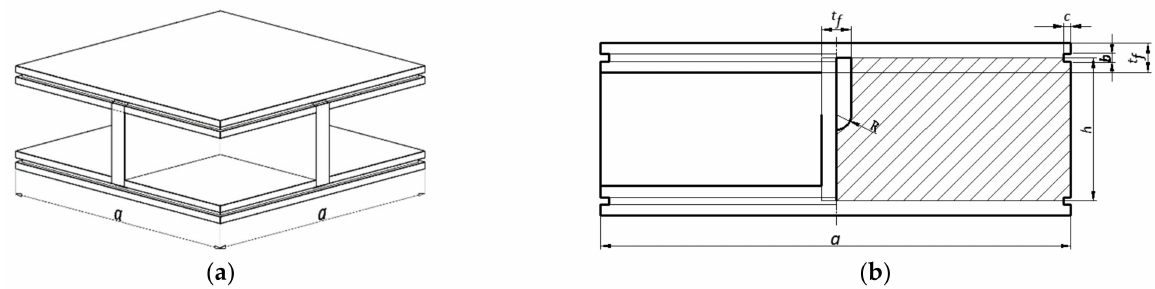
Figure 5. Diagram of interlocking grid structure. ( a ) Axonometric drawing; ( b ) section view.